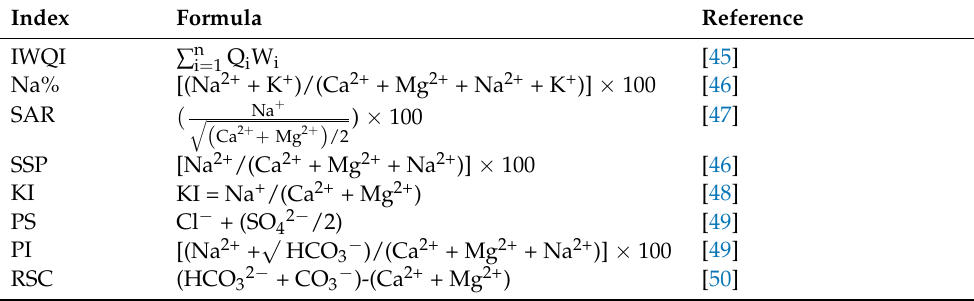
Table 1. The formula and references of the